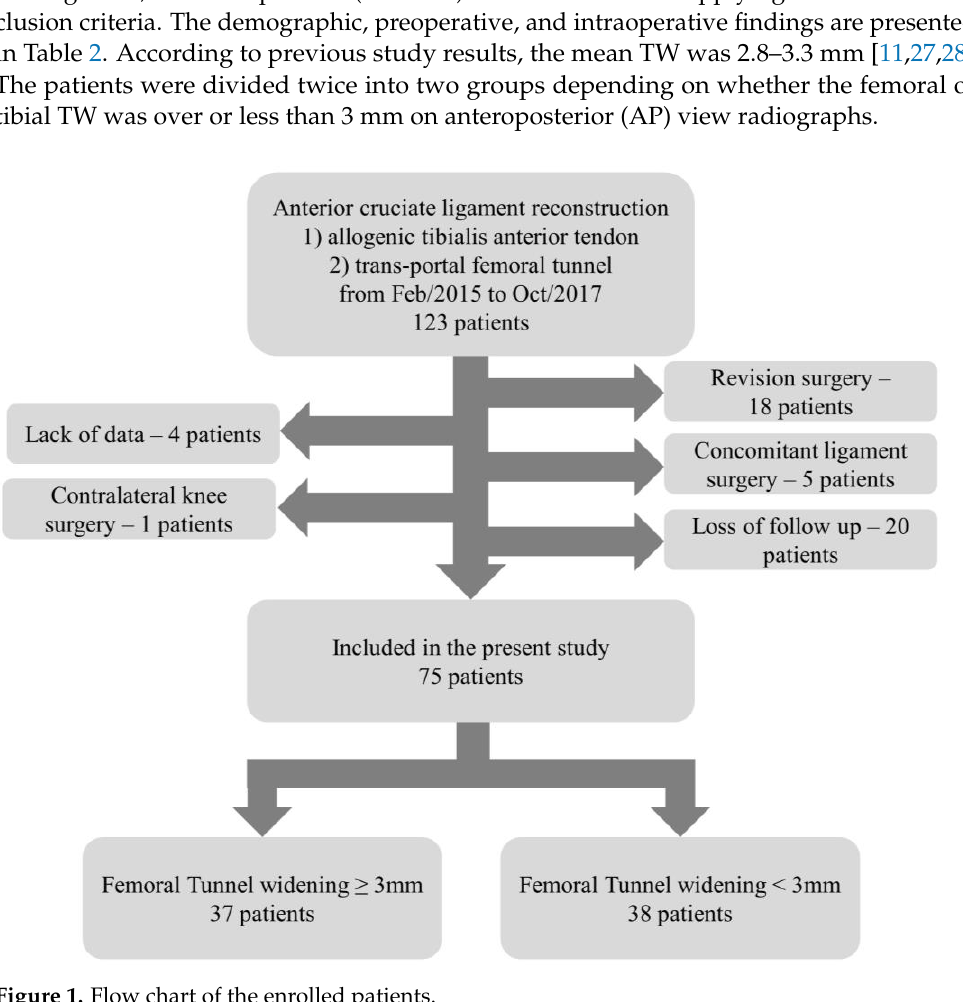
Figure 1. Flow chart of the enrolled patients. Table 2. Demographic, preoperative, and intraoperative data for enrolled patients.